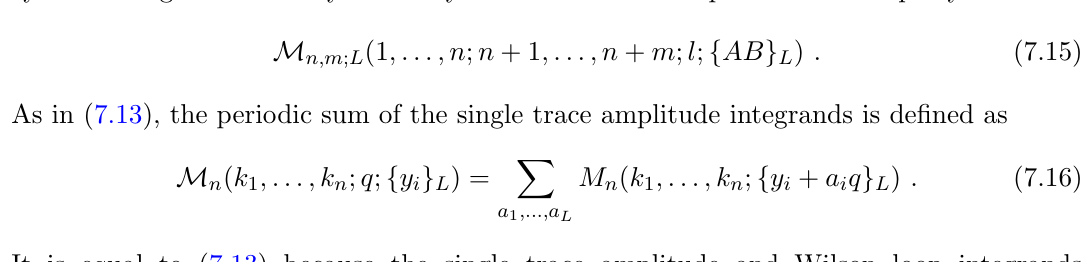
(cid:0) ^ x [ a ] ) 2 = 0, and are well separated from each 1 i